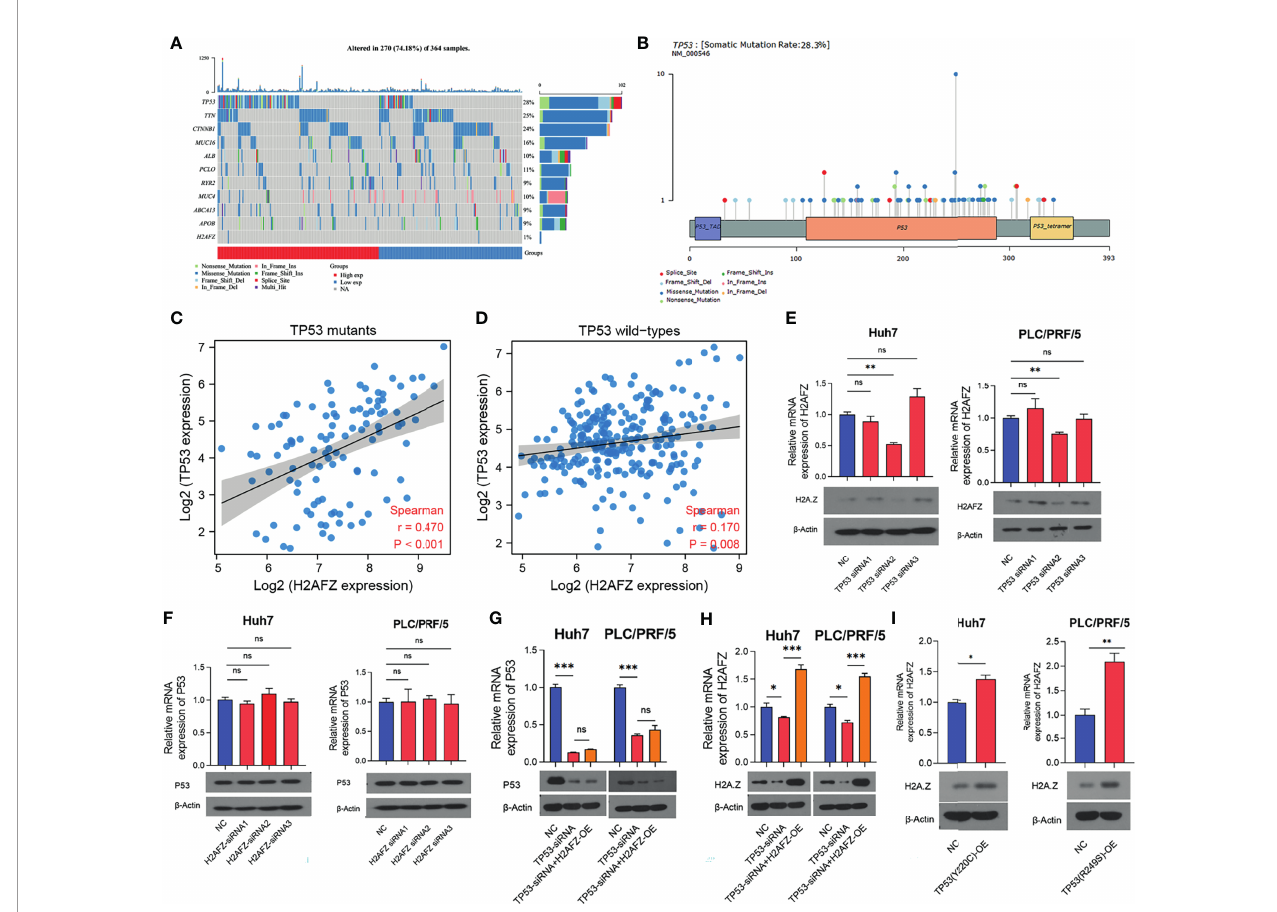
FIGURE 7 | H2AFZ expression was regulated by TP53 mutation in HCC. (A) Lollipop plot displaying mutation distribution and protein domains for TP53 in HCC with the labeled recurrent hotspots. Somatic mutation rate and transcript names were indicated by plot title and subtitle, respectively. (B) Oncoplot displaying the somatic landscape of 270 patients in the TCGA-LIHC cohort. Genes were ordered by their mutation frequency, and samples were ordered according to their H2AFZ expression. Side bar plot showed log10 transformed Q -values estimated by MutSigCV. Mutation information of each gene in each sample was shown in the waterfall plot, where different colors with speci fi c annotations at the bottom meant the various mutation types. (C, D) Co-expression of H2AFZ and TP53 in TP53 wild types (C) and TP53 mutants (D) in the TCGA-LIHC cohort. (E, F) Relative mRNA and protein expression level of H2AFZ in non-targeting control (NC)/TP53-siRNA1/TP53- siRNA2/TP53-siRNA3 Huh7 cells (E) and PLC/PRF/5 cells (F) . (G, H) Relative mRNA and protein expression level of TP53 in non-targeting control (NC)/H2AFZ- siRNA1/H2AFZ-siRNA2/H2AFZ-siRNA3 Huh7 cells (G) and PLC/PRF/5 cells (H) . (I) Relative mRNA and protein expression level of H2AFZ in NC/TP53-OE Huh7 and PLC/PRF/5 cells. T -tests ( n = 3), * p < 0.05, ** p < 0.001, *** p < 0.0001; ns, not signi fi